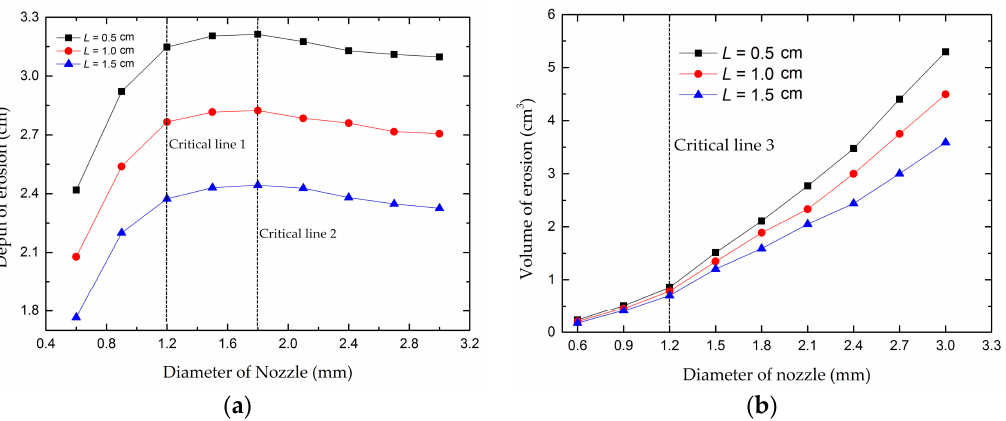
Figure 12. The erosion depth and the erosion volume versus nozzle diameter. ( a ) Depth of erosion; ( b ) volume of erosion.